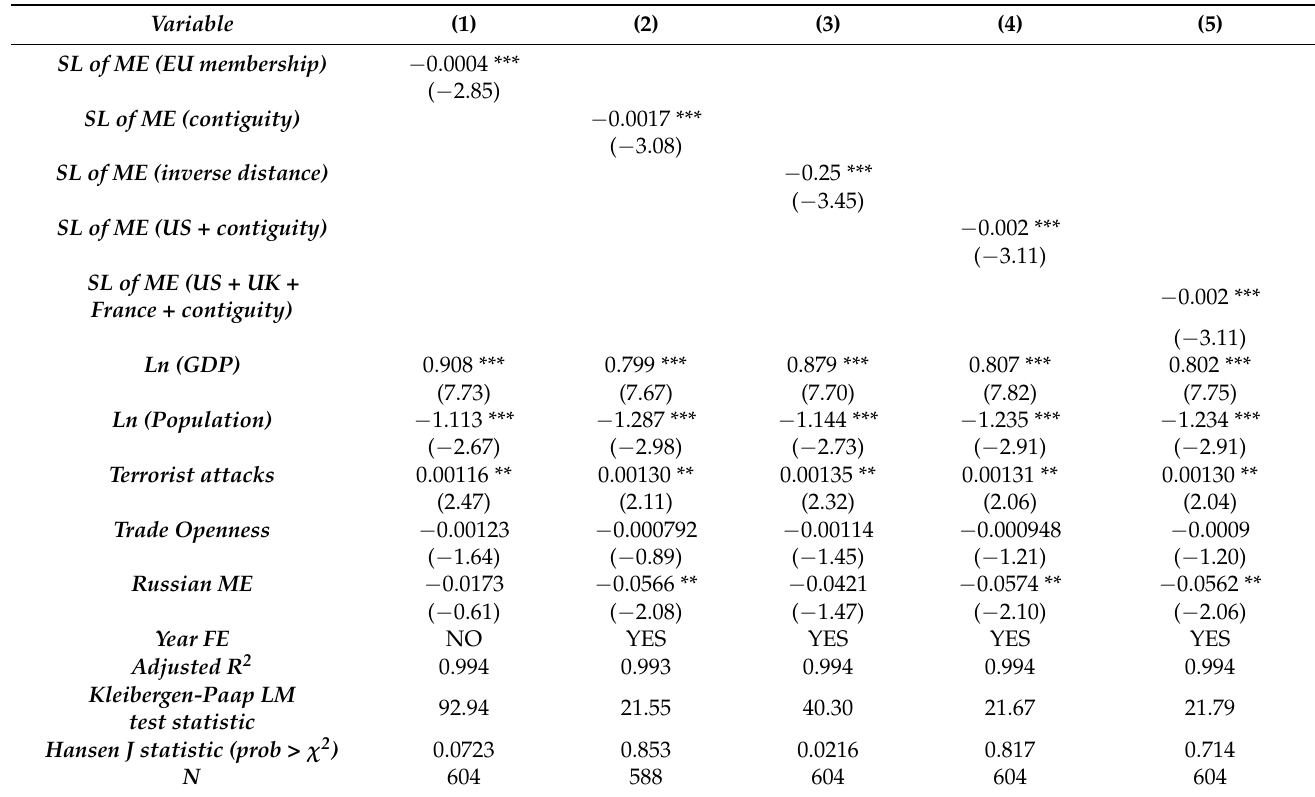
Table 5. EU military expenditure, 1990–2019 (alternate threat